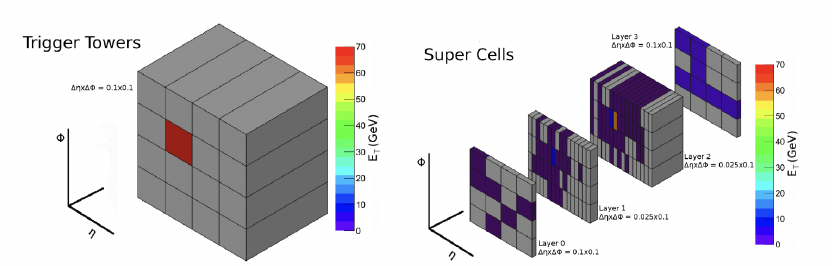
Figure 3. Simulation of the energy deposits of a 70 GeV electron reconstructed with the Run 2 Trigger Towers ( left ) and with the new Super Cells that will be used during Run 3 ( right )